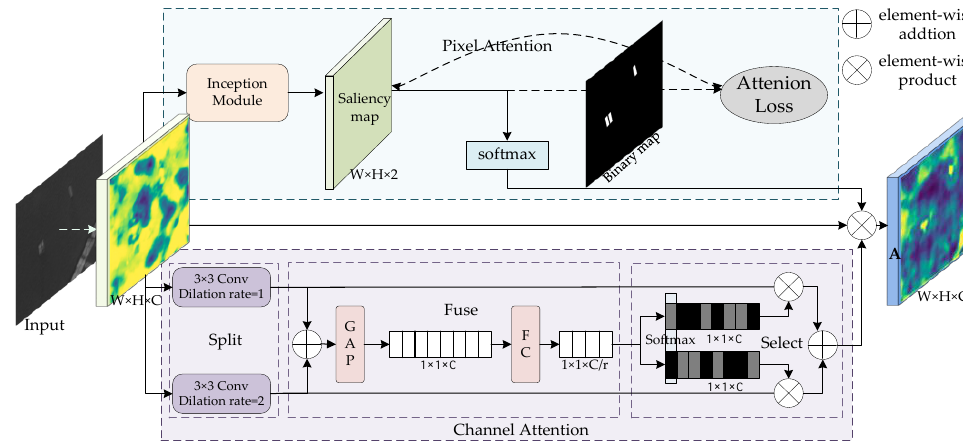
Figure 4. Hybrid attention mechanism.